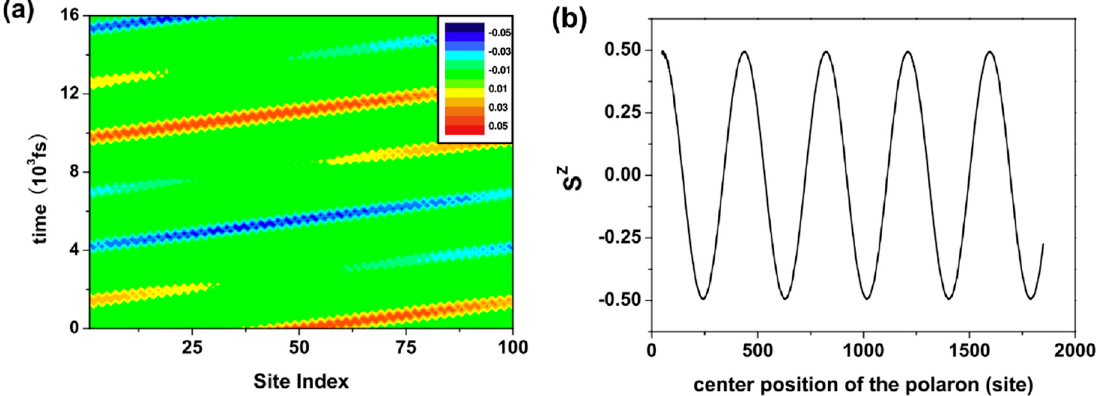
Figure 6. ( a ) Spin evolution of polarons, positive values denote spin up, negative values denote spin down and zero denote spinless; and ( b ) the polaron spin varies with the position of the center. By Lei et al. [33] with the permission of the Journal of Physics: Condensed Matter.